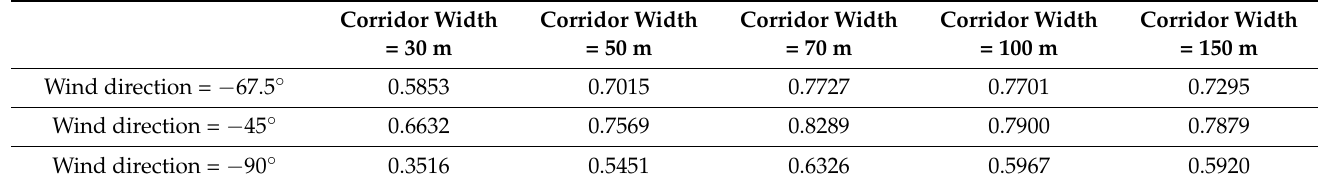
Table 4. Verification of the automatic mining of ventilation corridors.